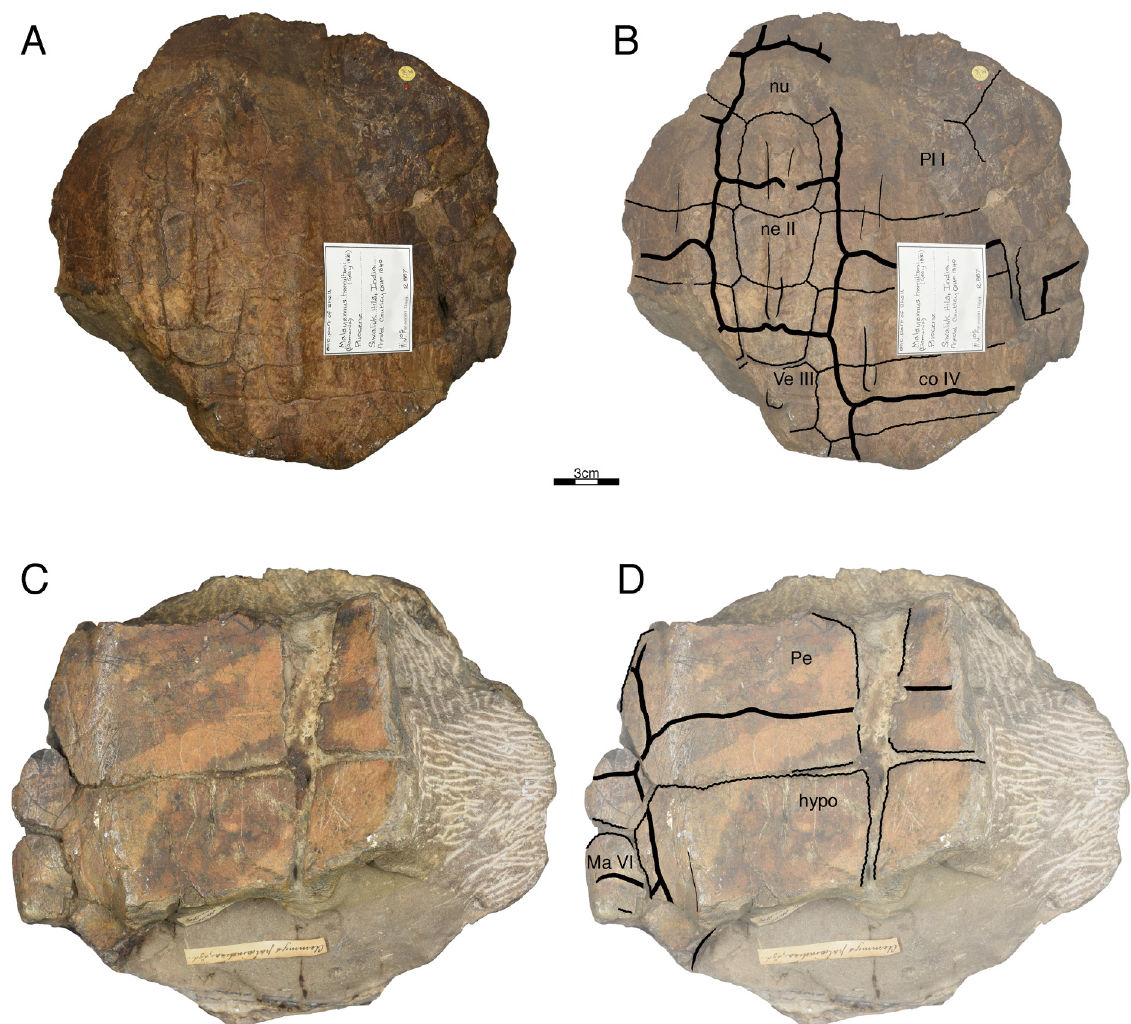
Fig. 25. BMNH R.887, referred to Damonia hamiltonii Gray, 1869 by Lydekker (1889b), here identified as Geoclemys hamiltonii (Gray, 1830). A . Photograph of carapace. B . Illustration of carapace. C . Photograph of plastron. D . Illustration of plastron. Scale bar: 3